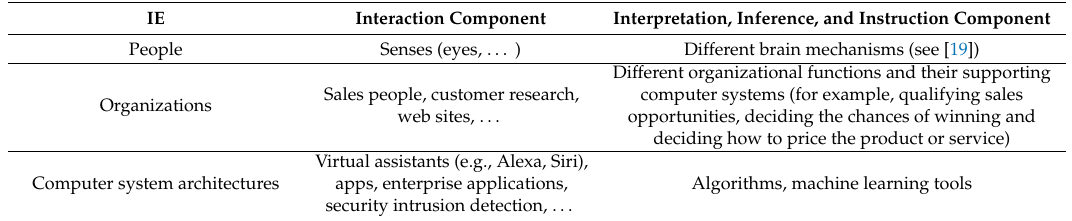
Table 2. Examples of